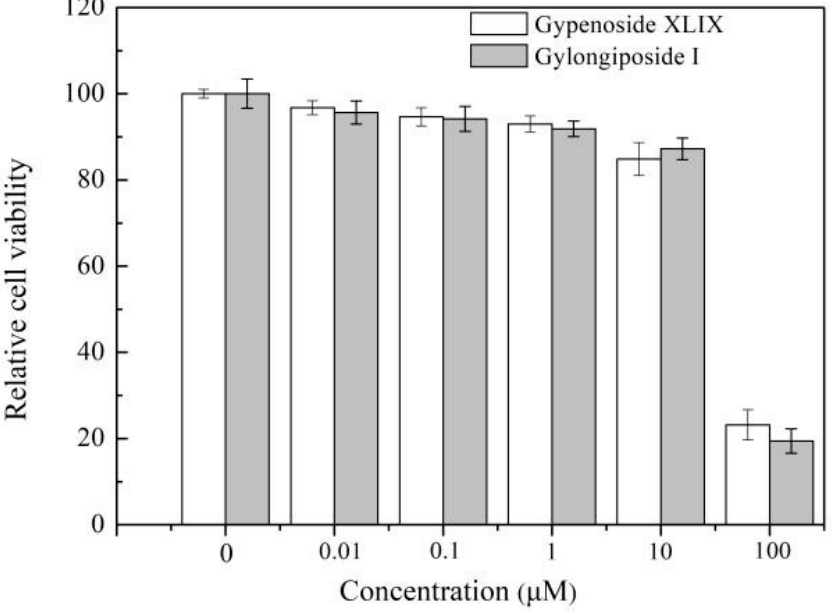
Figure 7. Dose-dependent cytotoxicity profiles of gypenoside XLIX and gylongiposide I were detected by a CCK8 kit in RD cells at 48 h. Inhibitory effect of gypenoside XLIX on EV71 replication in the 0.01 to 10 µ M dose range.